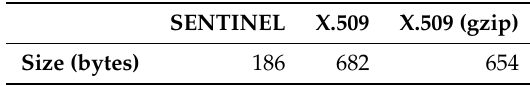
Table 2. Evaluation results of the size of certificates.